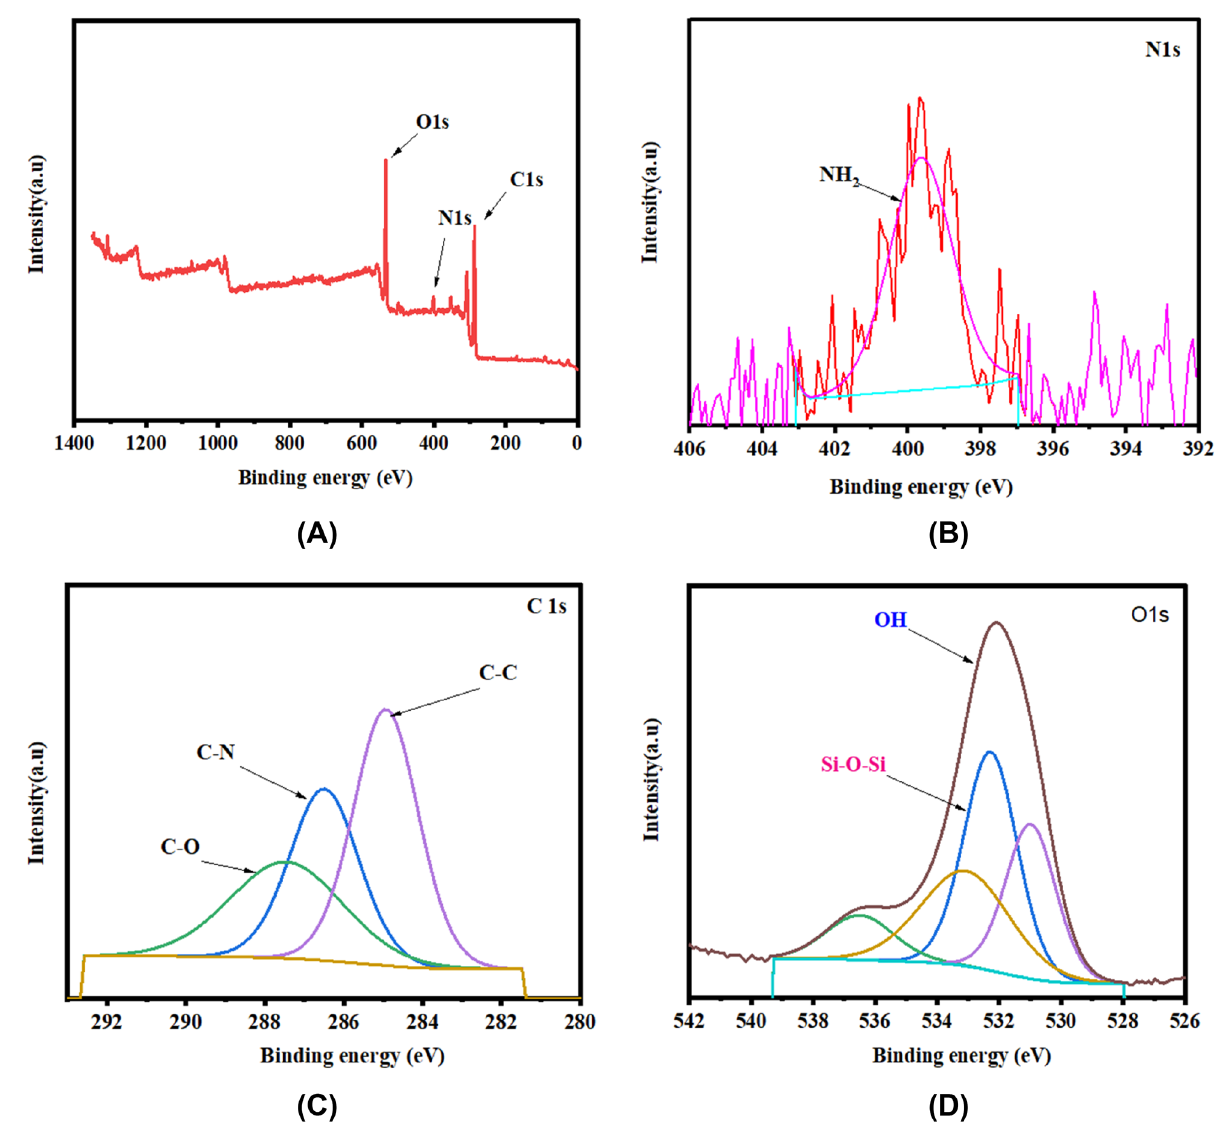
Figure 5. XPS spectra for ( A ) wide scan of K@AM-CTS composite beads, ( B ) N1s, ( C ) C1s and ( D )